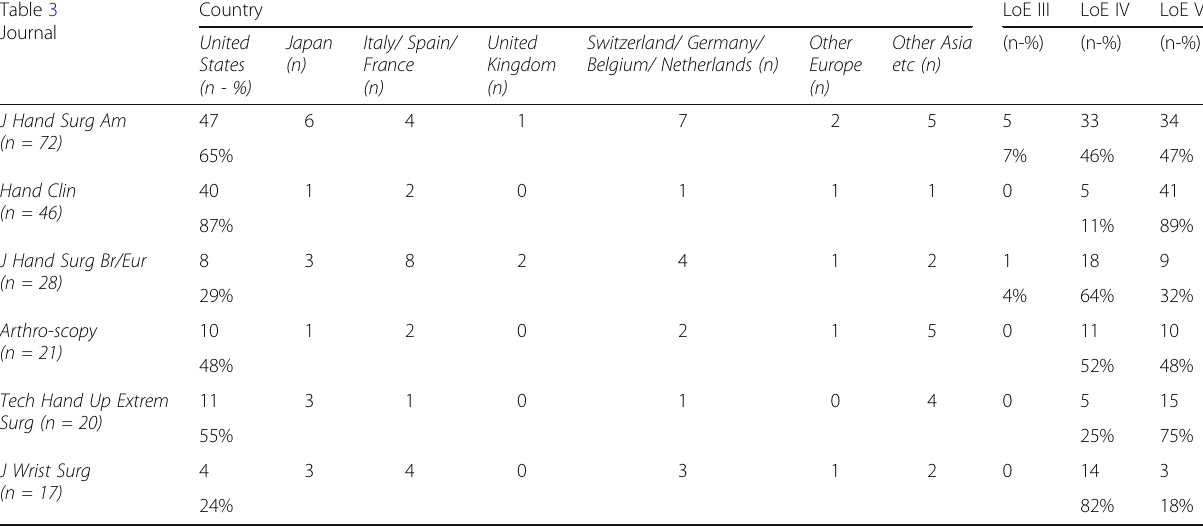
Table 3 Frequency table for geographic distribution combined with the level of evidence for the six most common journals Table 3 Journal